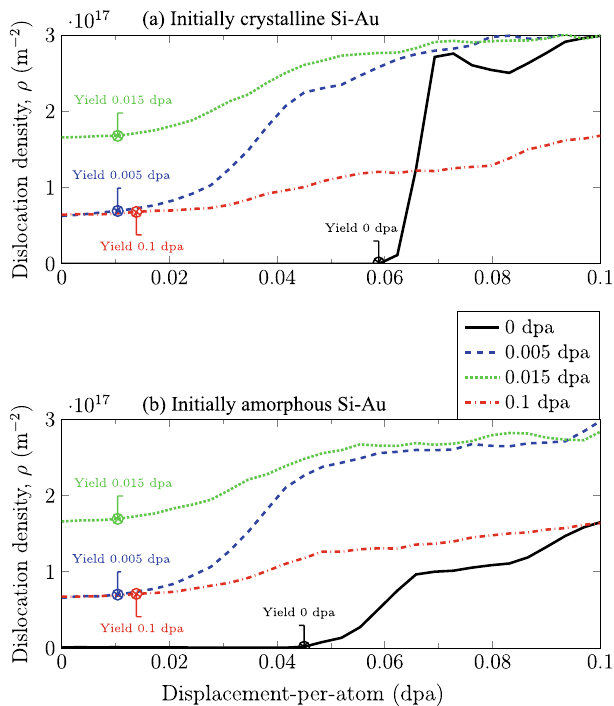
Figure 4. FCC Au dislocation density versus strain ǫ during biaxial compression at various damage levels. ( a ) Initially-crystalline Si–Au and ( b ) Initially amorphous